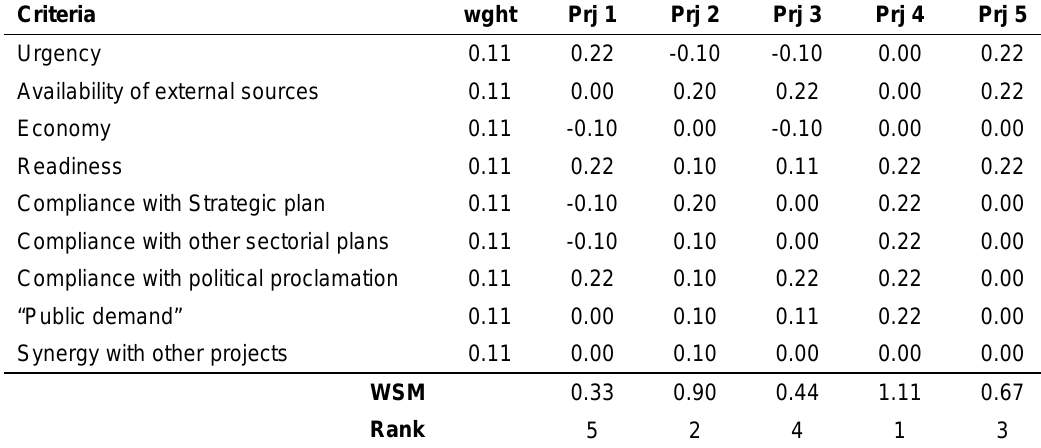
Table 3. Weighted sum method comparison with the same weight of criteria. Criteria wght Prj 1 Urgency 0.11 Availability of external sources 0.11